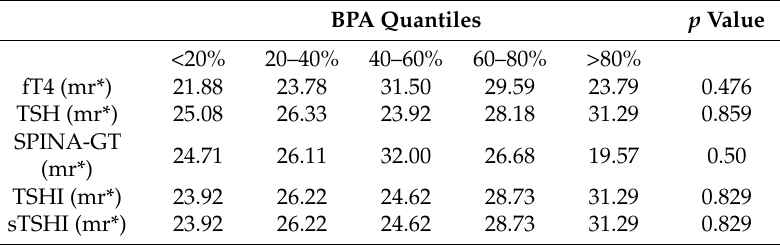
Table 4. Results of boys according to BPA